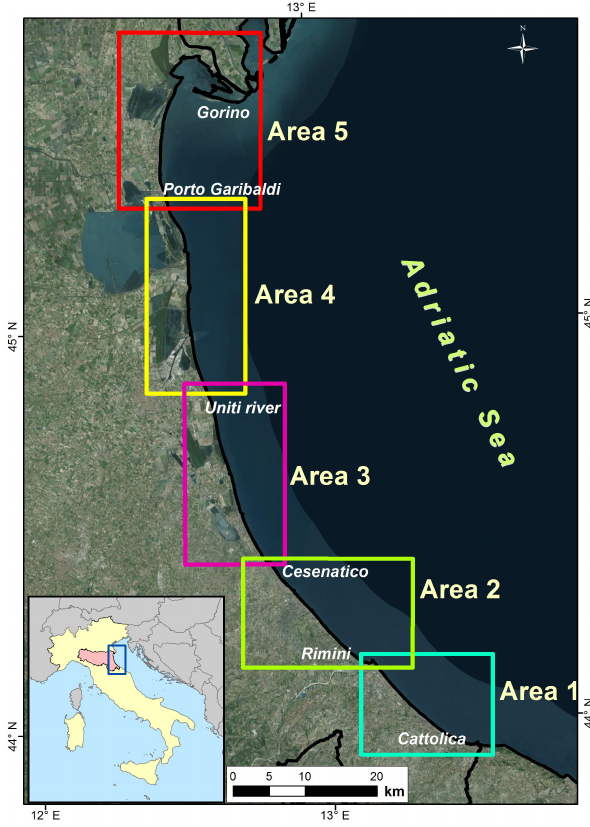
Figure 4. Location and boundaries of the five areas (areas 1 to 5) on which the E-R coastal plane has been divided.